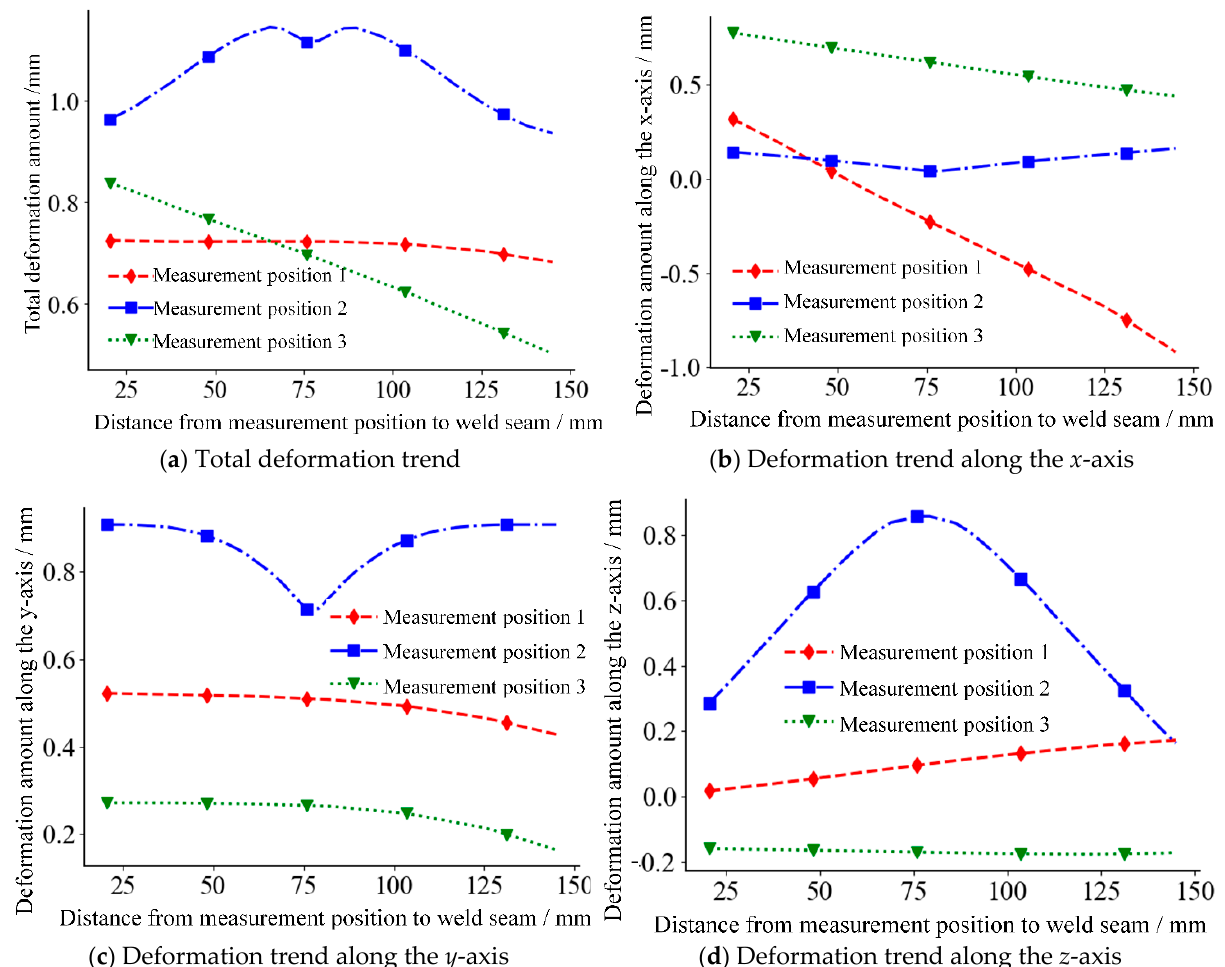
Figure 15. Deformation trend of welded structure 4 at different positions in the welding sequence of “ ③⑤⑥④②⑦①⑧ ”.